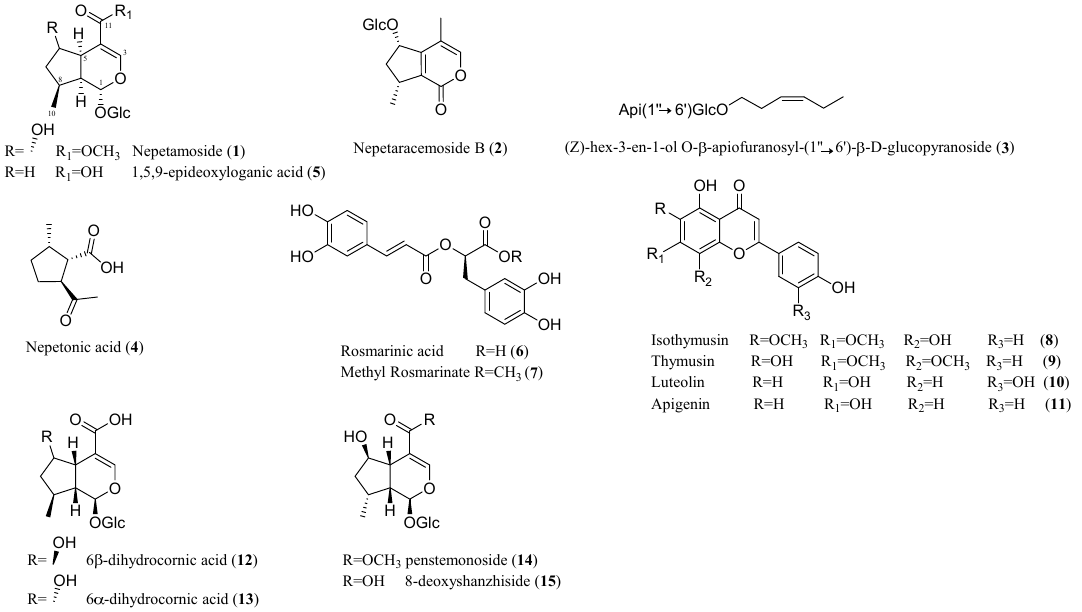
Figure 3. New ( 1 ) and known ( 2 – 11 ) compounds isolated from Nepeta asterotricha Rech. f. and compounds 12 – 15 as reference compounds reported in Tables 1 and 2.